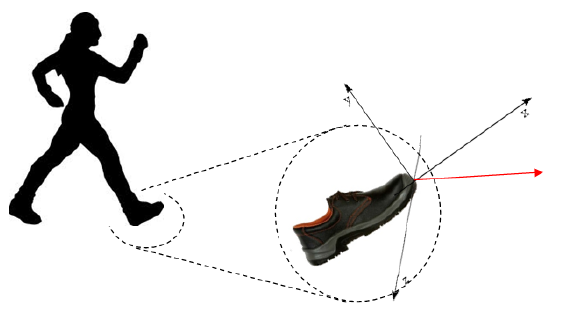
Figure 18. Representation of three directions during the walking.